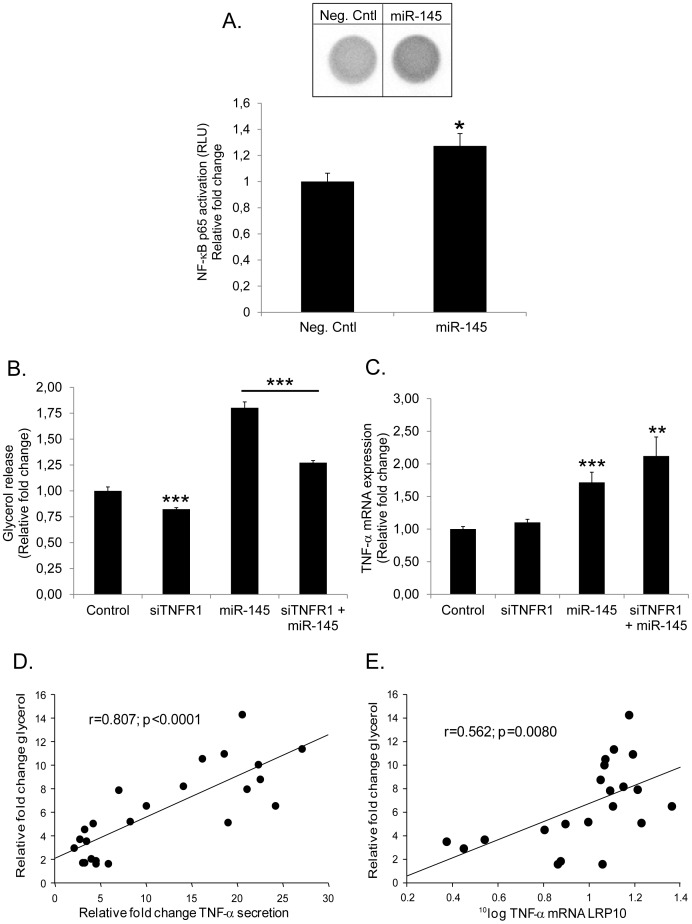
miR-145 alters TNF-α signaling and induces tightly correlated changes in lipolysis and TNF-α.(A) Human differentiated adipocytes were transfected with mimics miR-145 or Neg. Cntl (40 nM) for 15 h. After incubation time (15 h), nuclei were isolated and 2.5 µg of nuclear extract was used to perform p65 transactivation assay as described by manufacturer. Figure depicts representative wells of Neg. Cntl and miR-145-treated adipocytes and its relative quantification graph of three biological/independent experiments. Values are shown as mean ± SEM and expressed as relative fold change vs. Neg. Cntl. Statistical differences were analyzed by Student t-test: *p<0.05. (B) TNF-α receptor 1 (TNFR1) was silenced with siRNA for 24 h prior to co-transfection with miRNA Mimics (Neg. Cntl/miR-145) for additional 48 h in human differentiated adipocytes. After incubation time, conditioned medium was collected to measure glycerol release and cells were harvested for (C) TNF-α mRNA measurements. Results are representative of three biological/independent experiments. Values are shown as mean ± SEM. Statistical differences (vs. Neg. Cntl) were analyzed by Student t-test: **p<0.01; ***p<0.001. (D) Correlation between glycerol vs. TNF-α secretion (measured in conditioned medium/supernatant) and vs. (E) TNF-α mRNA levels in miR-145-transfected adipocytes in vitro for 48 h. Values are expressed as relative fold change vs. Neg. Cntl. (in D and E) after correction by transfection efficiency and were compared by linear regression. Each dot represents a technical replicate from 7–8 biological/independent experiments.